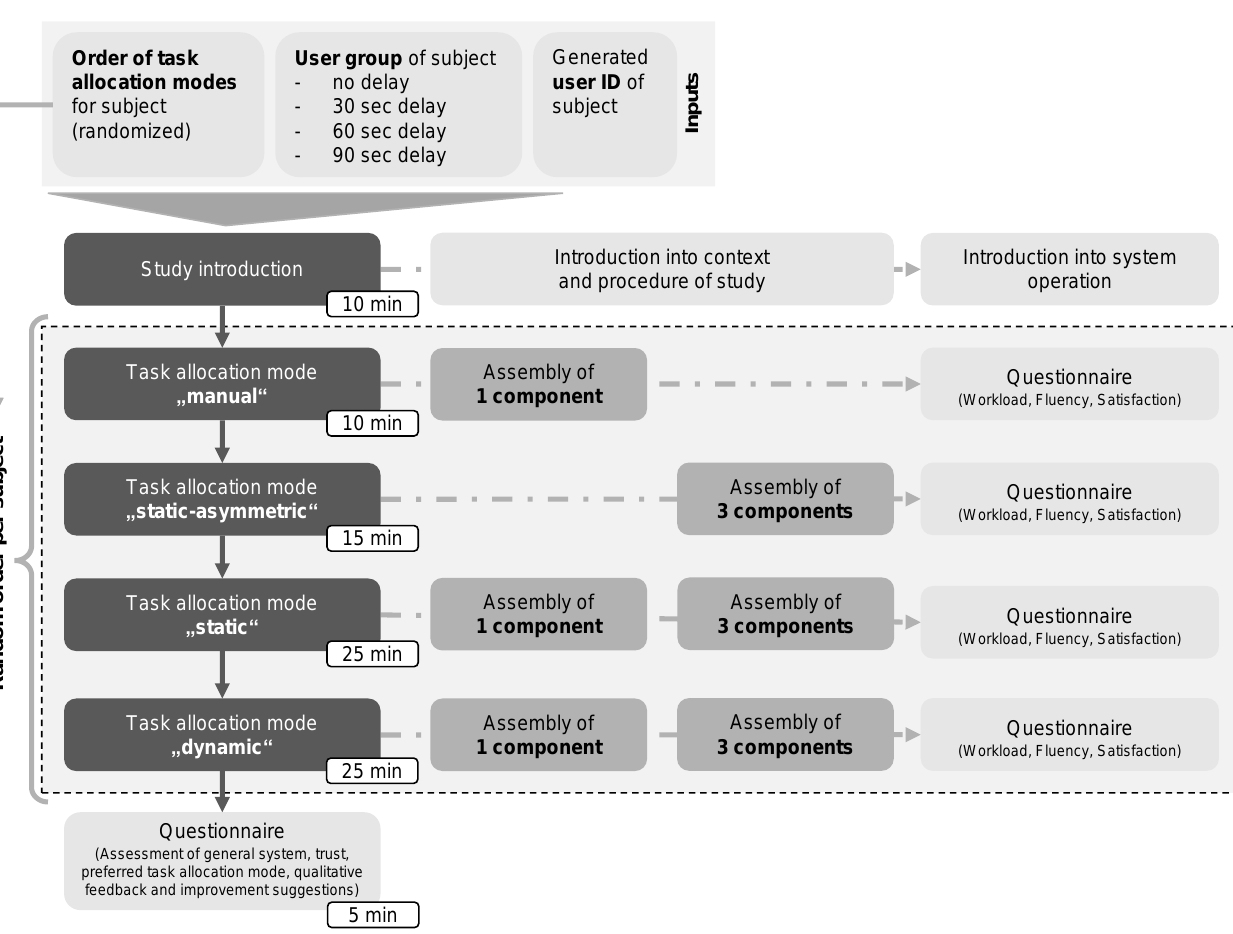
Figure 16. Procedure of the user study.